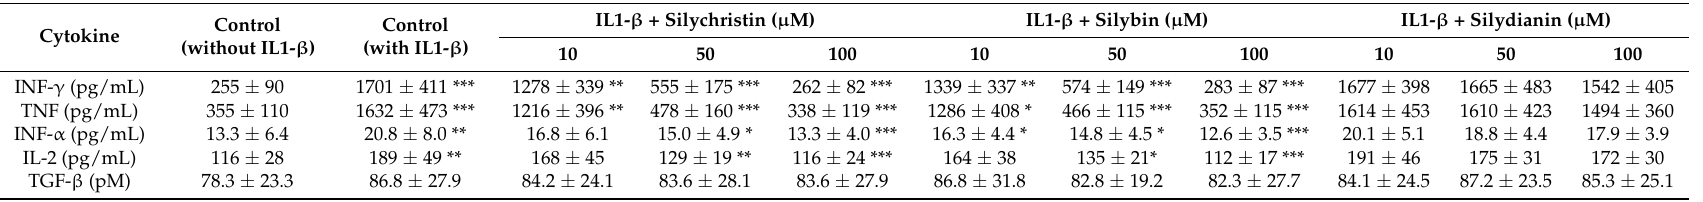
Table 1. The effect of flavonolignans; silychristin, silybin and silydianin in concentrations of 10, 50, and 100 µ M on the IL-1 β (10 ng/mL) induced the production of pro-inflammatory cytokines (IL-2, TNF, INF- α , INF- γ , TGF- β ). The levels of pro-inflammatory cytokines were estimated in plasma obtained from whole blood samples treated with IL-1 β and flavonolignans and presented as a mean of concentration ± SD, n = 12; * p < 0.05, ** p < 0.01, *** p < 0.001. Control Cytokine (without IL1- β ) INF- γ